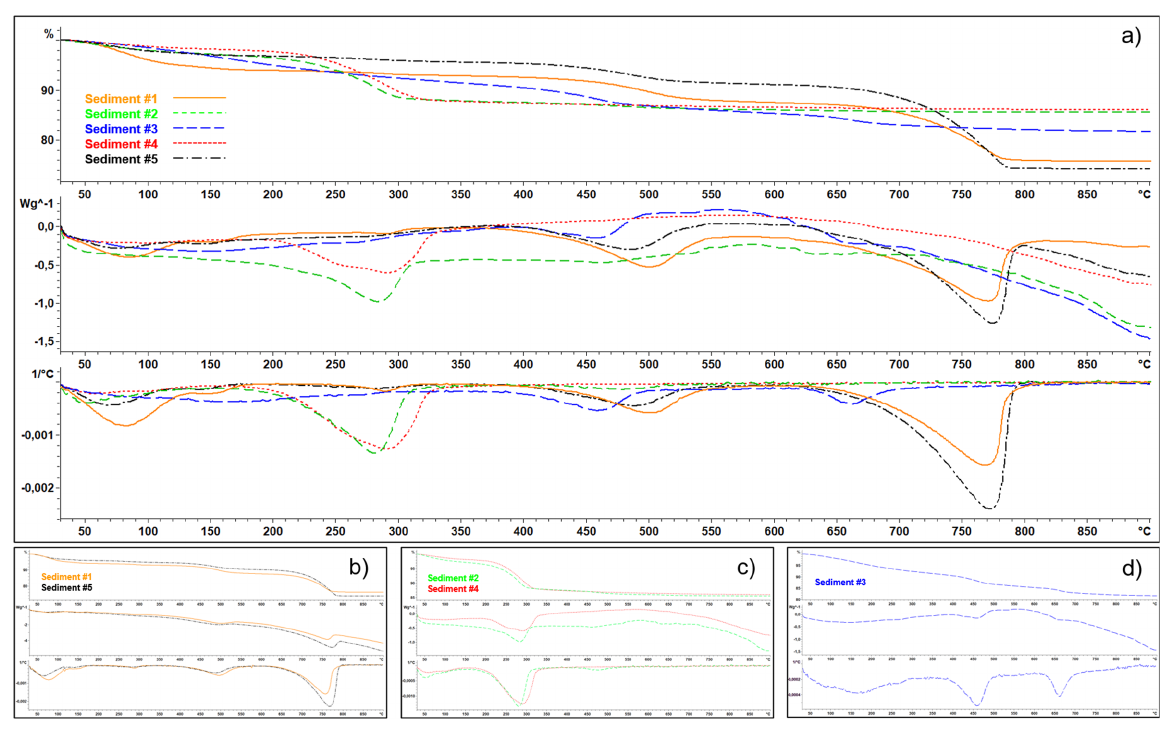
Figure 4. Thermogravimetric (TG; in the top), differential scanning calorimetry (DSC; in the middle) and first derivative (in the bottom) curves of: ( a ) all sediments; ( b ) sediment #1 vs. #5; ( c ) sediment #2 vs. #4; and ( d ) sediment #3.